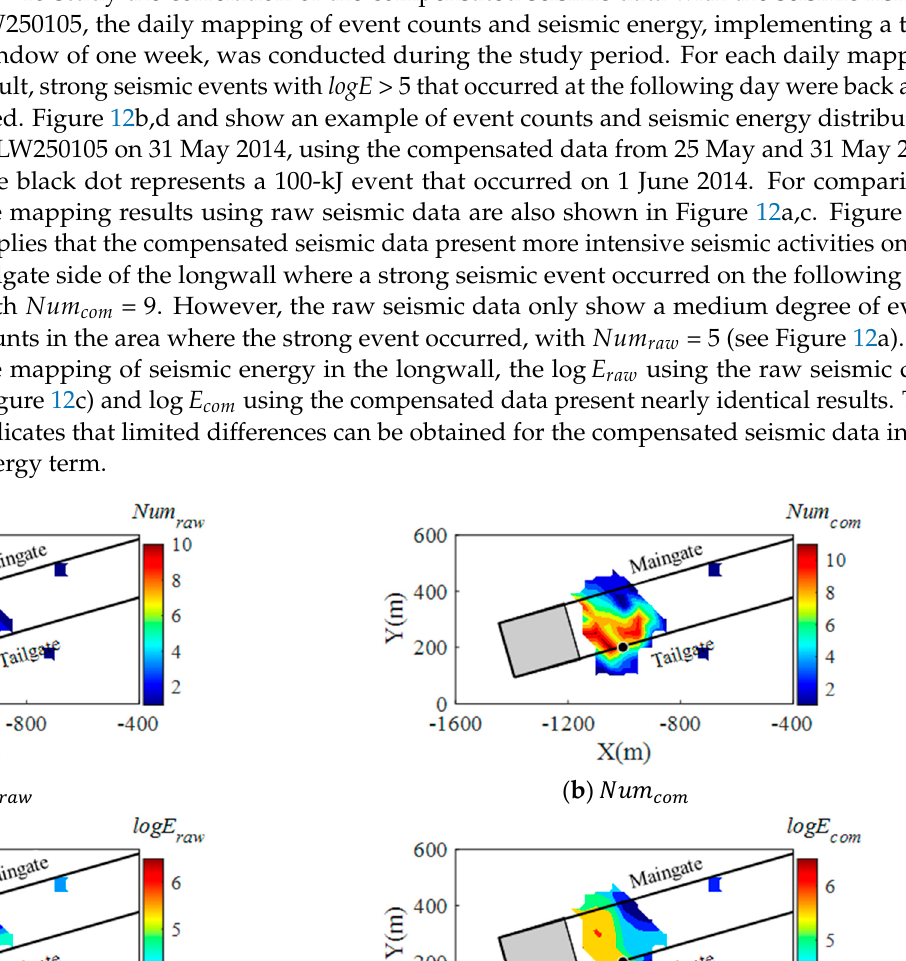
Figure 11. Distribution of average seismic energy ahead of the longwall face in LW250105 using compensated seismic data ( 𝐸 𝑐𝑜𝑚 ) and raw seismic data ( 𝐸 𝑟𝑎𝑤 ).